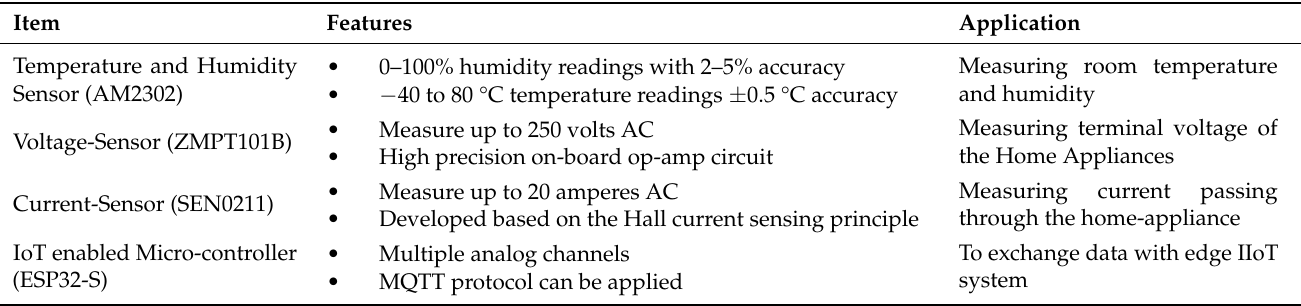
Table 2. Parts of the